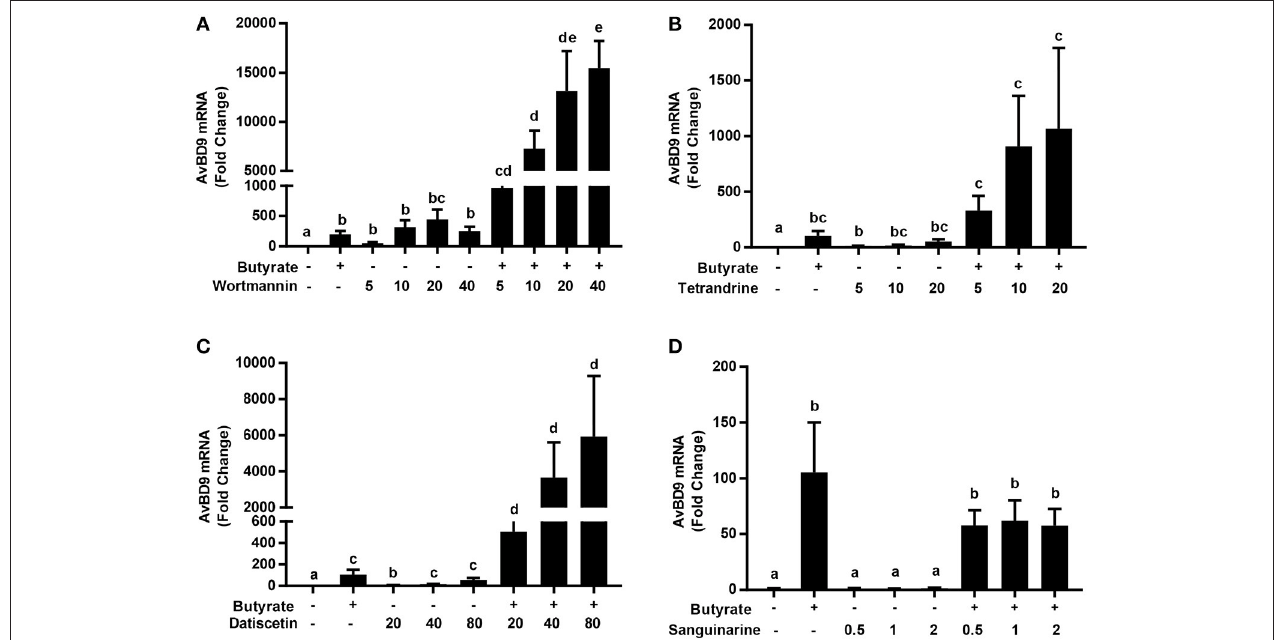
FIGURE 8 | Synergistic induction of AvBD9 mRNA expression in HTC cells between butyrate and three newly identified natural products. Chicken HTC cells were treated with 4mM butyrate in the presence or absence of different concentrations of wortmannin (A) , tetrandrine (B) , datiscetin (C) , or sanguinarine (D) for 24h, followed by RT-qPCR analysis of AvBD9 mRNA expression. The results are means ± SEM of 2–3 independent experiments. The bars without common superscript letters denote statistical significance (by unpaired Student’s t -test). It is noted that an obvious synergy in AvBD9 gene expression was observed between butyrate and any of wortmannin, tetrandrine, datiscetin, but not between butyrate and